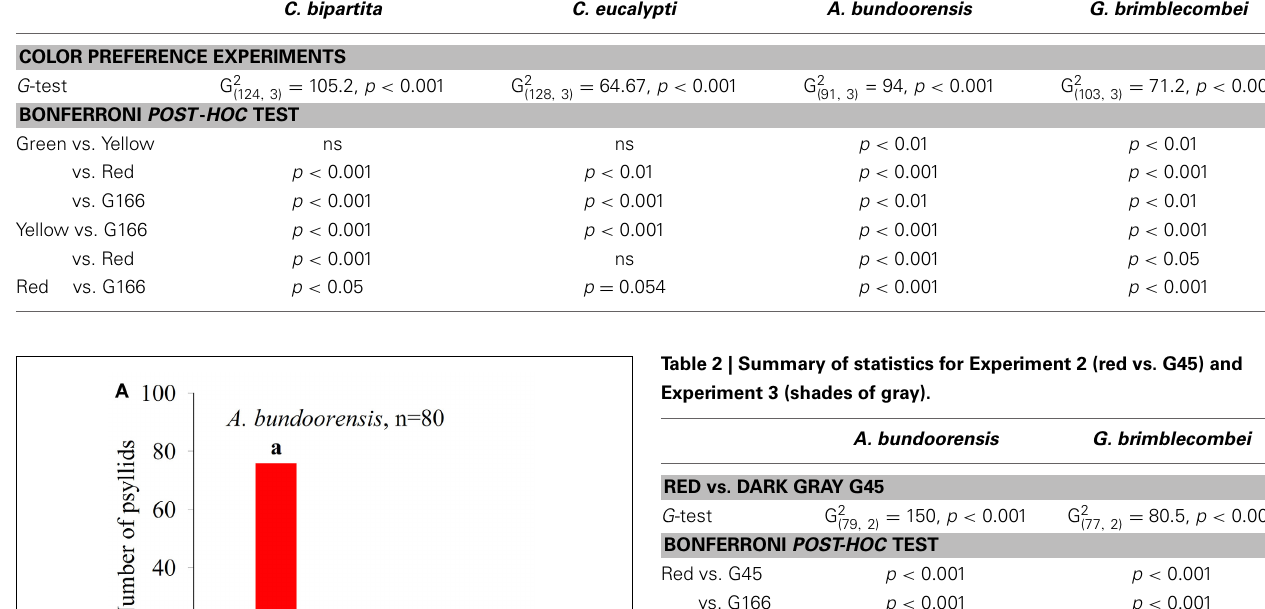
Table 1 | Summary of statistical tests of bioassays with colored stimuli (Experiment 1).